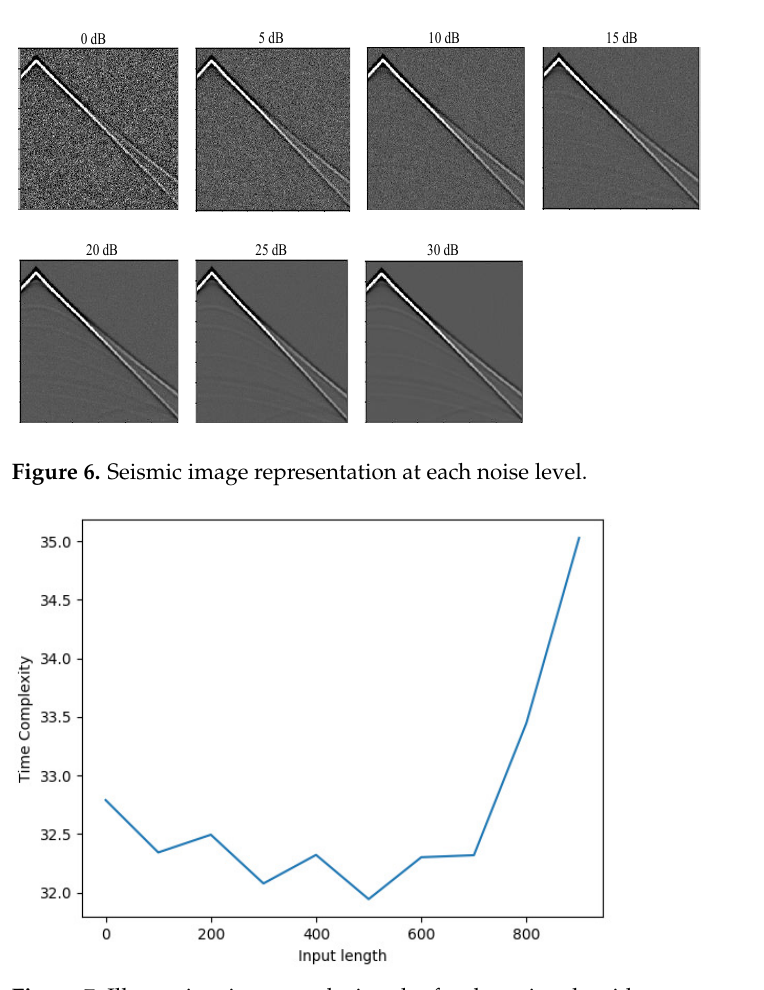
Figure 7. Illustrative time complexity plot for the noise